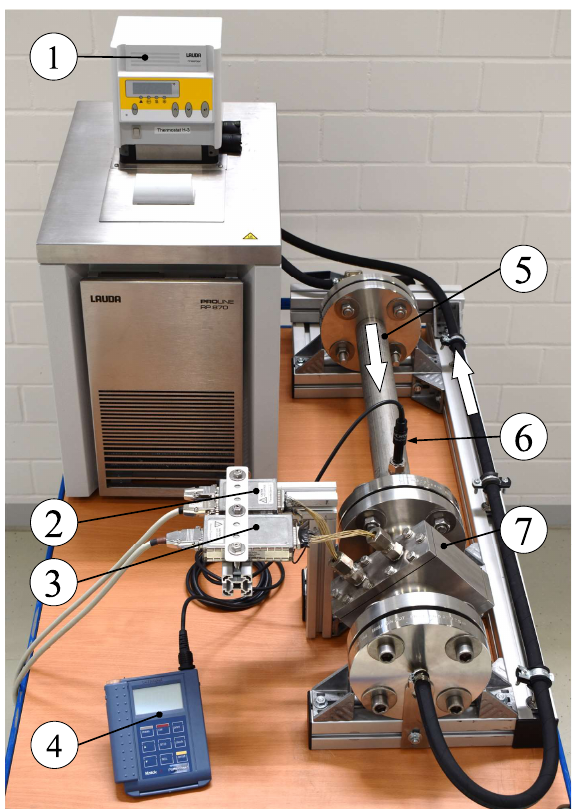
Figure 2. Experimental set-up comprising: (1) thermostat, (2) transmitter module, (3) receiver module, (4) measurement device for conductivity and temperature, (5) test section with (6) conductivity and temperature probe and (7) industrial wire-mesh sensor. White arrows indicate flow